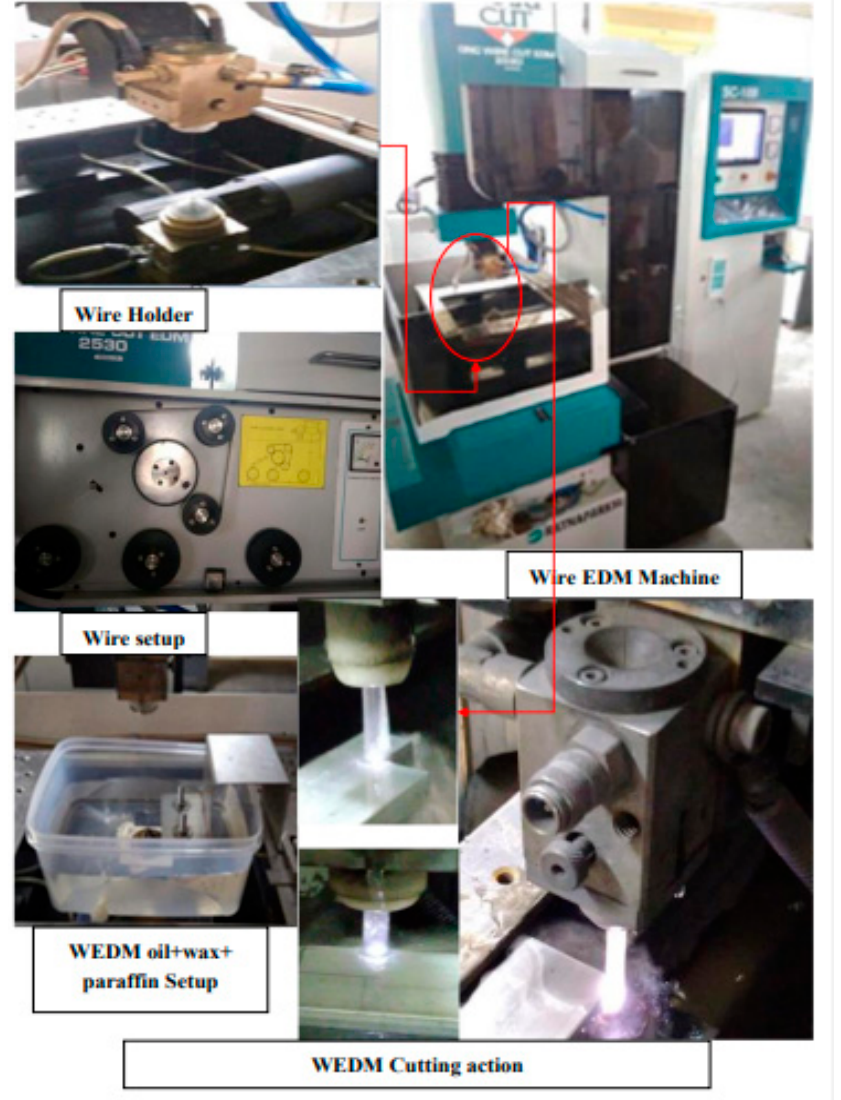
Figure 2. Wire electrical discharge machining setup and cutting action.